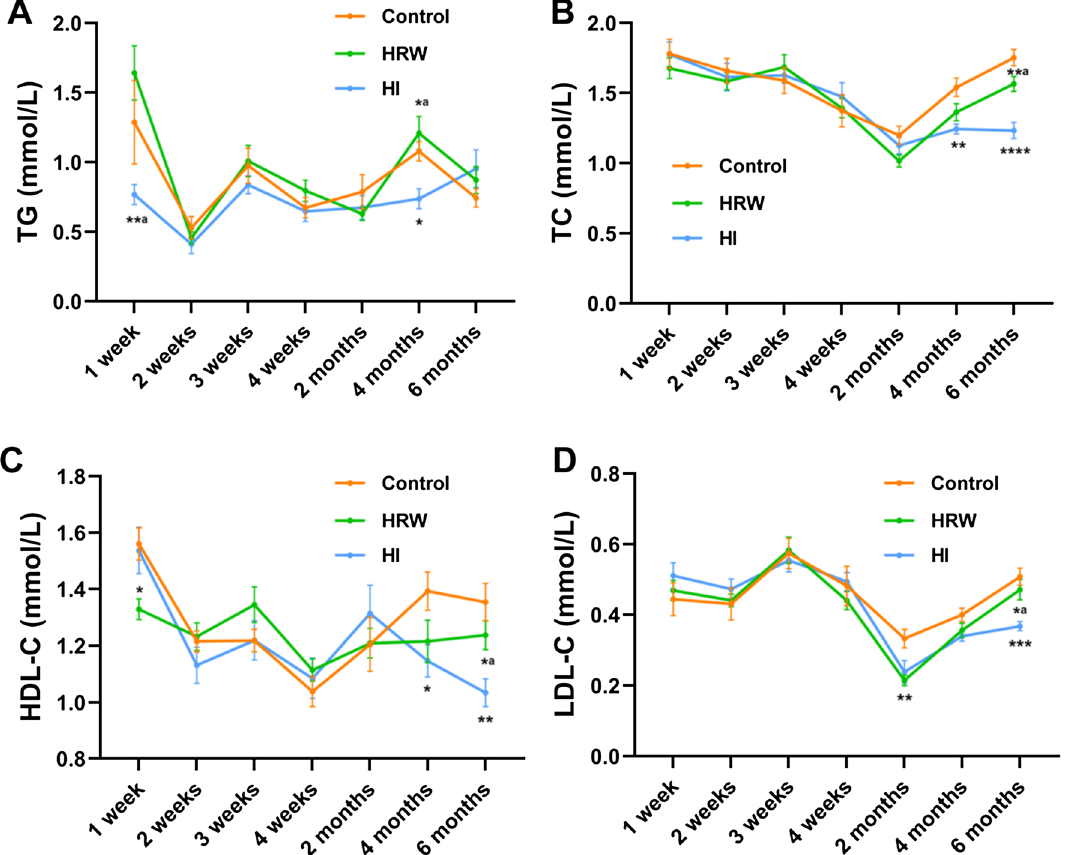
Figure 4. Effects of hydrogen treatment on serum lipid and apolipoprotein. The levels of serum TG (A) , TC (B) , HDL-C (C) and LDL-C (D) were monitored throughout the experimental period. Values shown are mean ± SEM (n = 10). For comparison of HRW or HI group and Control group, * p < 0.05, ** p < 0.01. Figure was made with GraphPad Prism 8.0.2, https ://www.graph pad.com/suppo rt/faq/prism -802-relea se-notes .